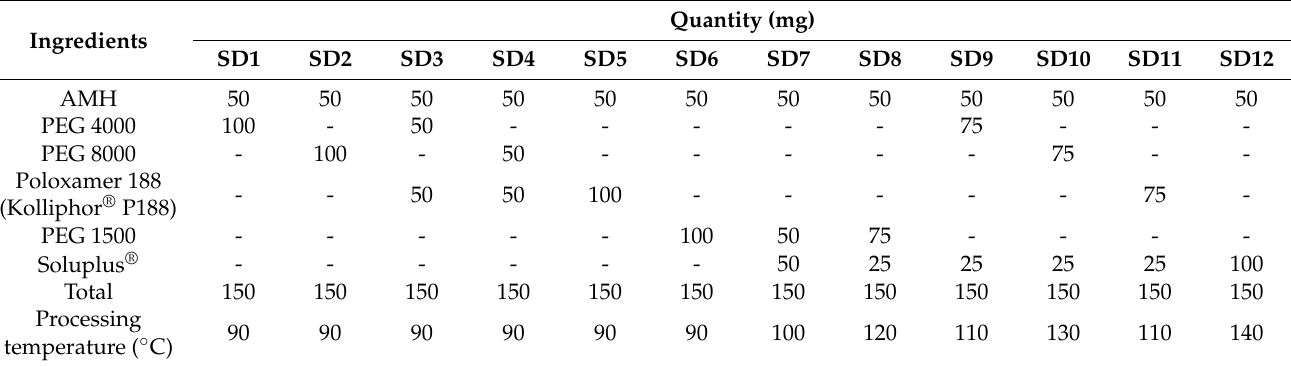
Table 1. The solid dispersions formulations and the processing